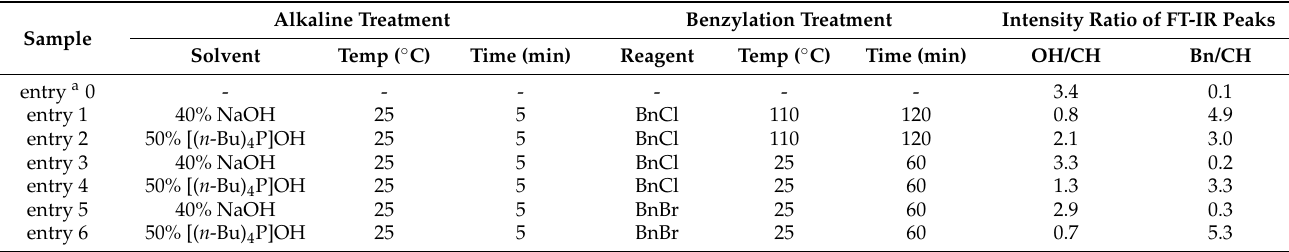
Table 1. Treatment conditions of benzylation and the intensity ratio of the FT-IR